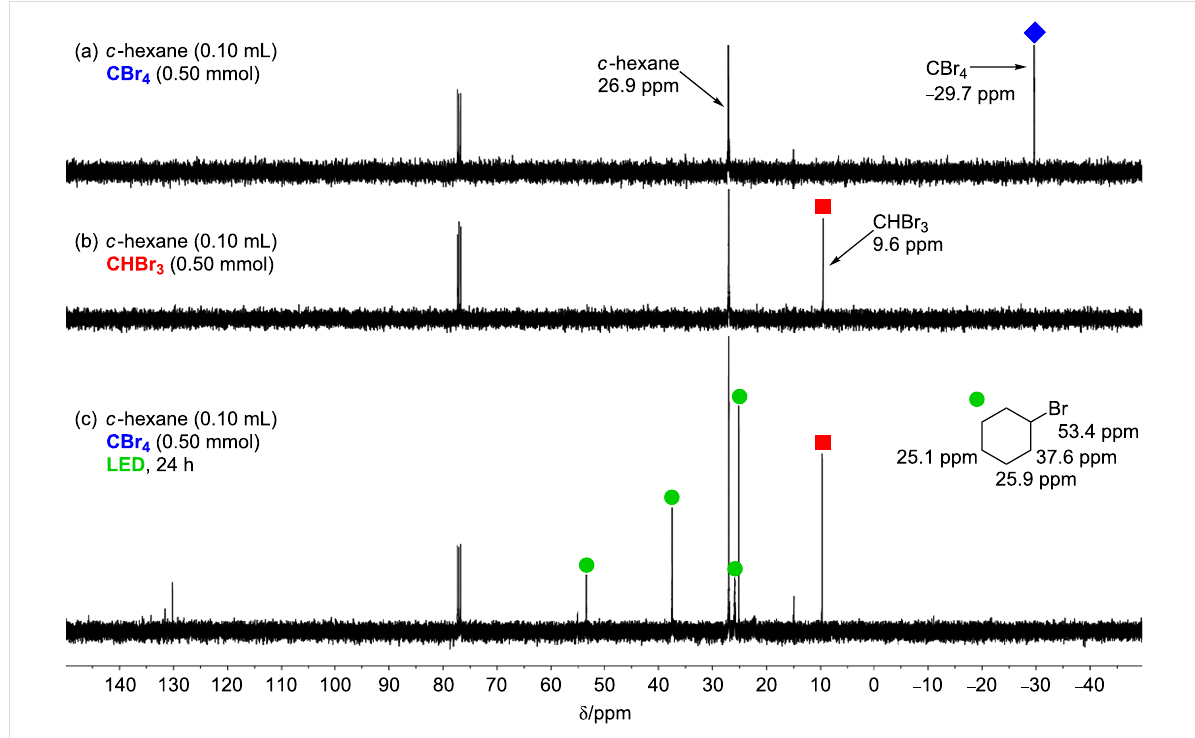
Figure 2: 13 C NMR monitoring of reaction mixtures: (a) 0.50 mmol of CBr 4 , 0.10 mL of cyclohexane, and 0.40 mL of CDCl 3 , (b) 0.5 mmol of CHBr 3 , 0.10 mL of cyclohexane, and 0.40 mL of CDCl 3 , (c) 0.50 mmol of CBr 4 and 0.10 mL of cyclohexane, LED irradiation for 24 h, and then addition of 0.40 mL of CDCl 3